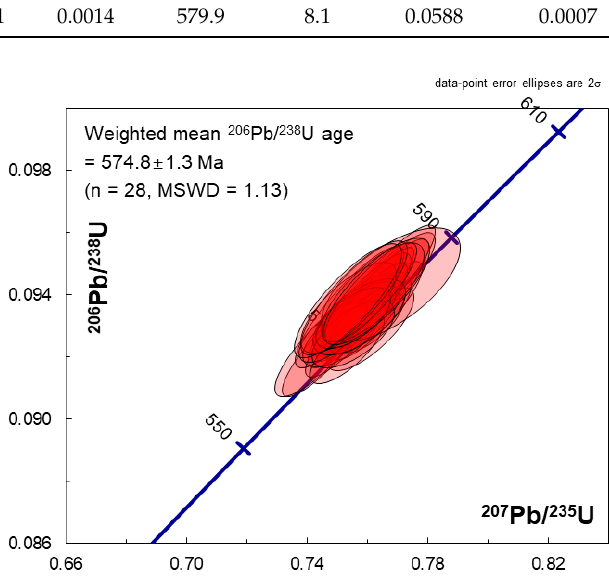
Figure 3. 206 Pb / 238 U– 207 Pb / 235 U concordia diagram showing LA-MC-ICPMS results for the LKZ-1 Figure 3. 206 Pb/ 238 U– 207 Pb/ 235 U concordia diagram showing LA-MC-ICPMS results for the LKZ-1 zircon zircon with ± 2 σ error with ±2 σ error ellipses. Table 4. U–Pb isotopic data for the LKZ-1 zircon obtained by ID-TIMS.